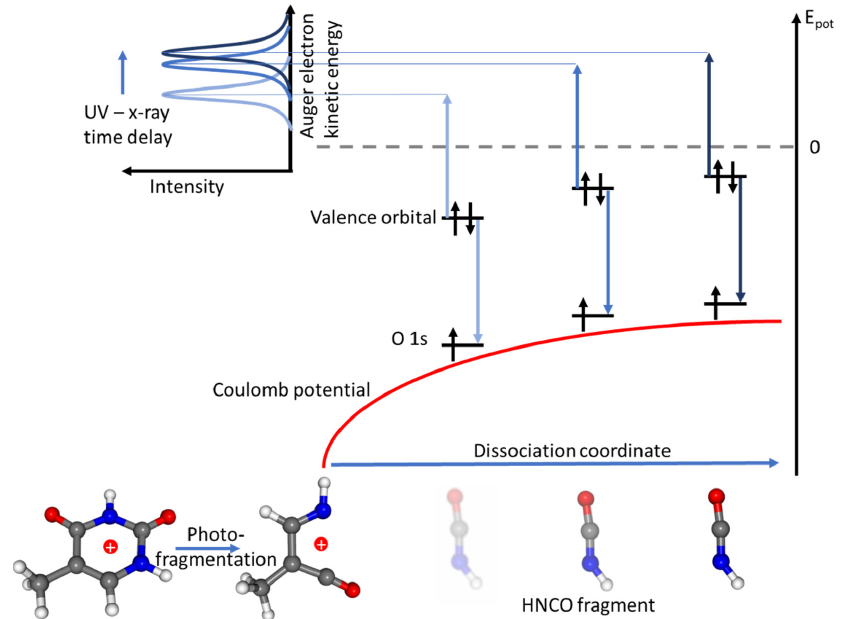
Figure 1. Probing molecular photofragmentation by soft X-ray-induced Auger spectra. We exemplify the method on the thymine molecular cation, which breaks apart into neutral isocyanic acid (HNCO) and singly-charged C 4 H 5 NO + after three-photon UV ionization (bottom). The distance of the HNCO fragment is interrogated by a time-delayed soft X-ray pulse creating core ionized molecules. The subsequent Auger decay leads to the emission of an additional electron, which does not only have to overcome the ionization potential intrinsic to the molecule, but also the external Coulomb potential (red) of the nearby cationic fragment. The Auger emission from the small neutral HNCO in the vicinity of the positively-charged large fragment leads to a red-shifted Auger kinetic energy with respect to the Auger electron spectrum of the isolated molecule. As the dissociation coordinate increases, the redshift asymptotically disappears.